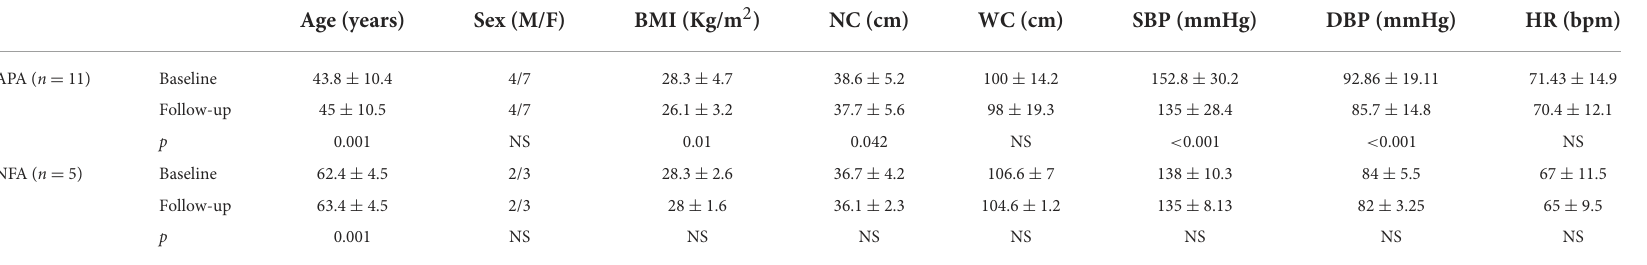
TABLE 1 Demographic and anthropometric data of all patients at baseline compared to follow-up.